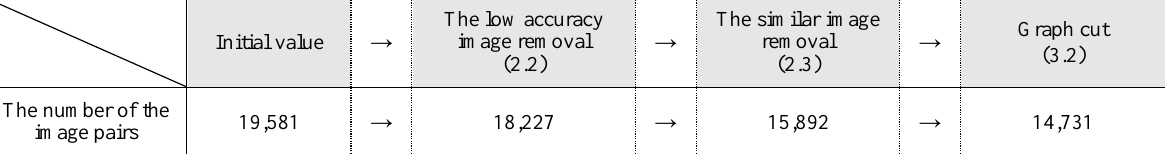
Table 1. A change of the number of the use image pairs in each stage